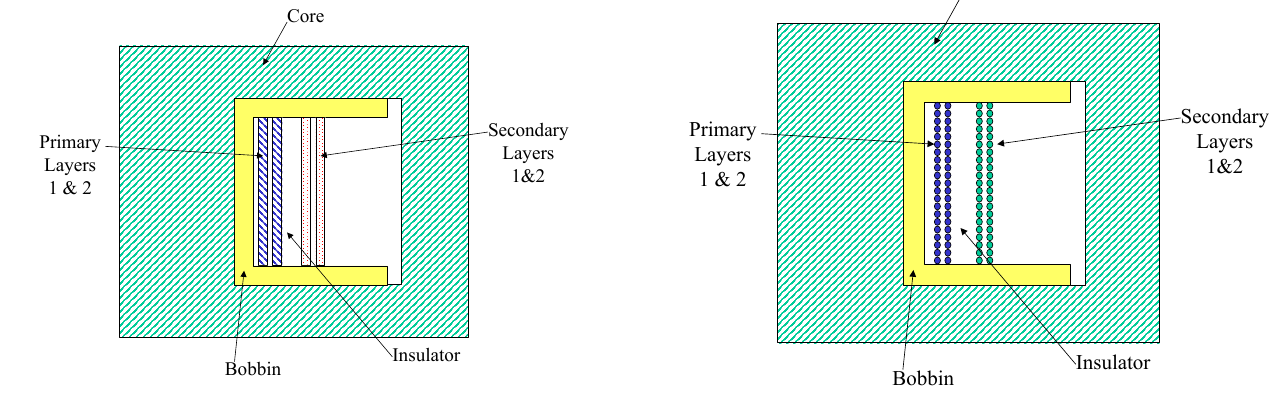
Figure 7: Turn by Turn 2D Model